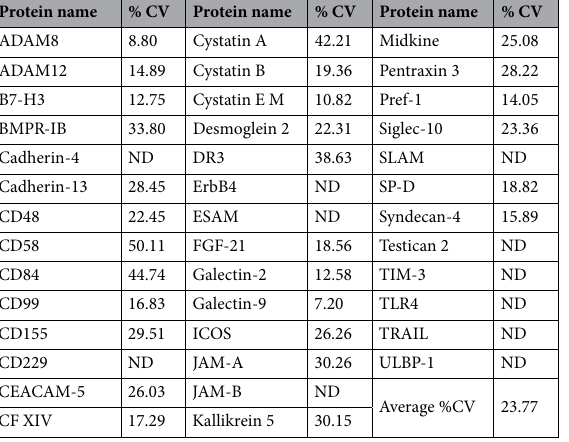
We tested whether these proteins are also measurable in DBSs. Of the 40 FDA-approved markers tested, 18 were measurable in at least 2/3 of all DBSs tested, whereas 28 were measurable in at least 2/3 of all serum samples tested. Expression levels for these 18 and 28 targets, respectively, were reasonably well correlated with normal serum values reported in the literature despite the differences in sample type (in the instance of DBSs), individuals tested, and quantification methods (R 2 value of 0.81 and 0.64 for DBSs and serum samples, respectively) (Fig. 8D). Validation in single-plex assays for clinical use is often required for biomarkers identified in large scale, multi- plex analyses. Similarly, there are a number of well-known biomarkers, including cancer markers CA72-4 and CA125, that are often used independently in single-plex assays. Therefore, we tested 5 matched DBS and serum samples on single-plex ELISAs for CA72-4 and CA125 (Table 2). The results showed good correlation between serum and DBS for these 2 proteins (adjusted R-squared = 0.7002 and 0.9717 for CA125 and CA72-4, respectively)